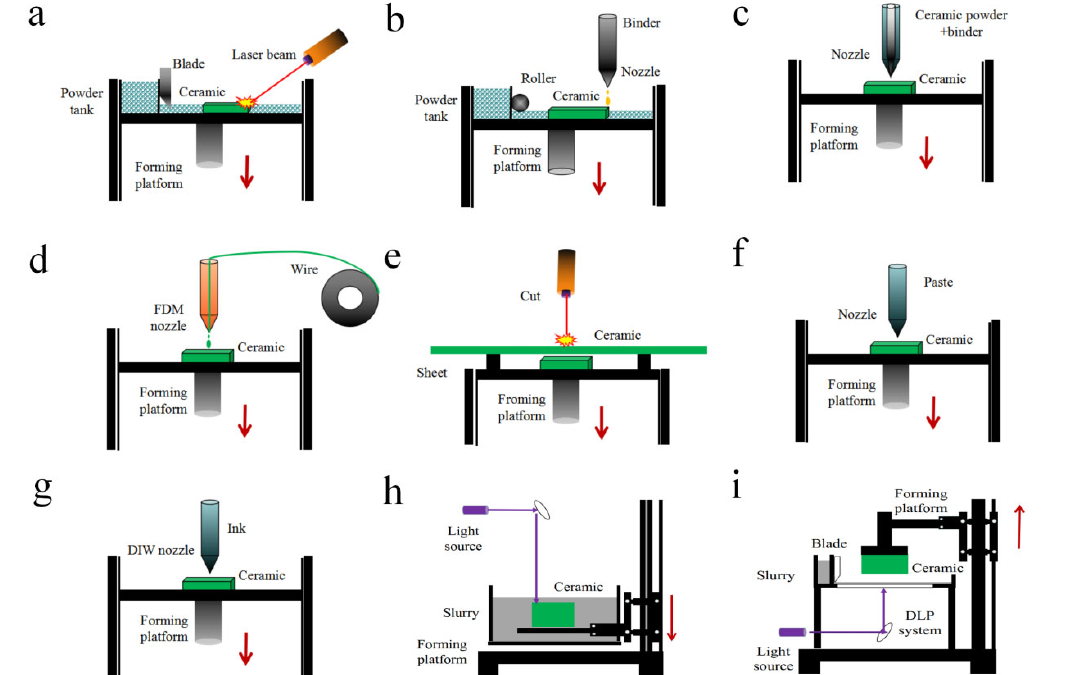
Fig. 9 Schematic drawing of various direct additive manufacturing technologies of SiC ceramic: (a) SLS, SLM, LPBF; (b) BJ; (c) 3DP; (d) FDM; (e) LOM; (f) robocasting, EFF; (g) DIW; (h) SLA; (i)